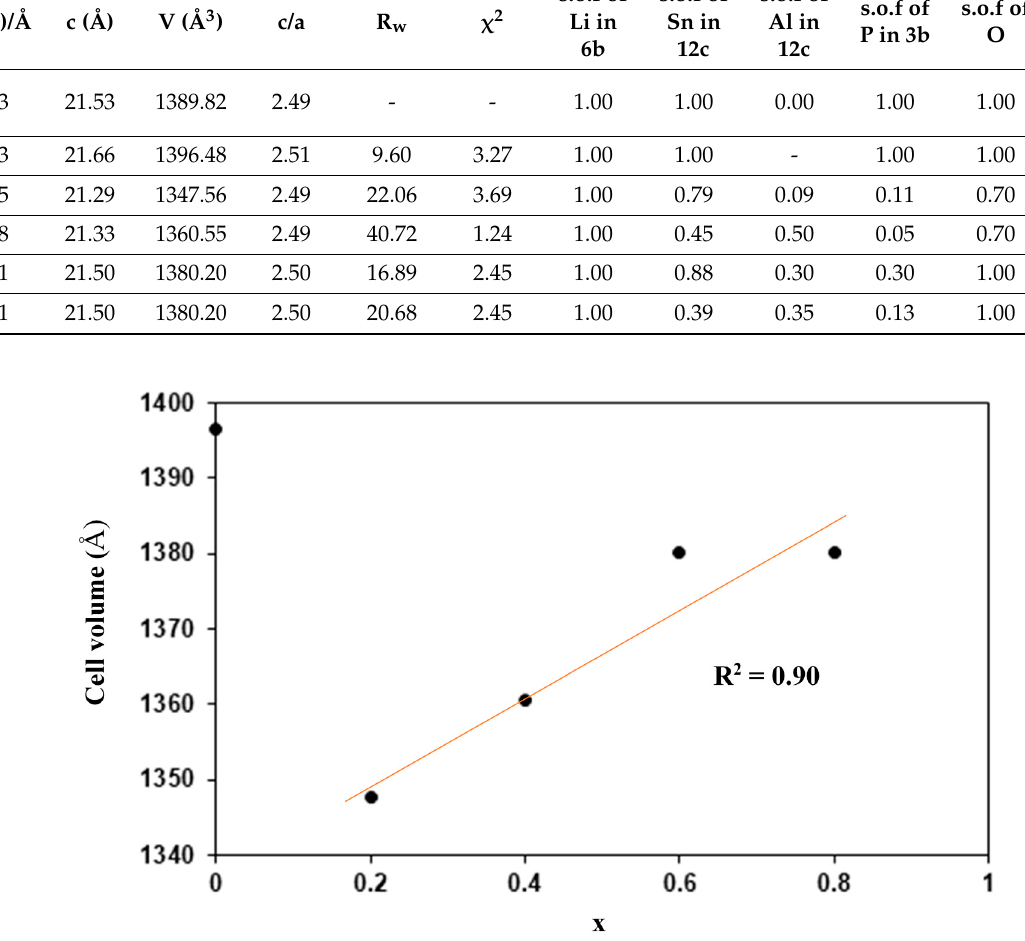
Figure 3. Cell volume versus x values.